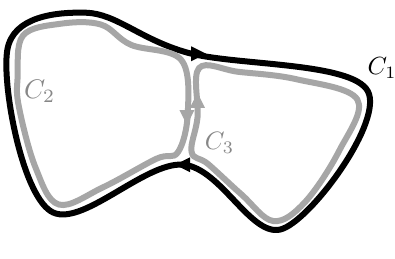
Figure 2: Example of three curves C δ [ C − C + C ] has 1 2 3